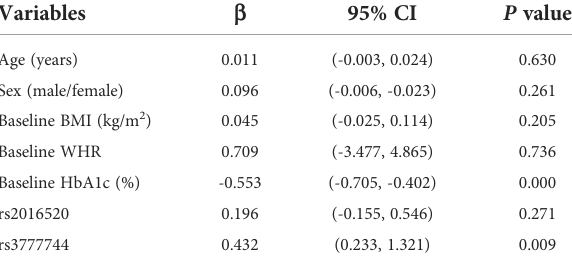
TABLE 5 Multiple linear regression analysis of HbA1c improvement after 6 months of exenatide treatment (n = 105). Variables